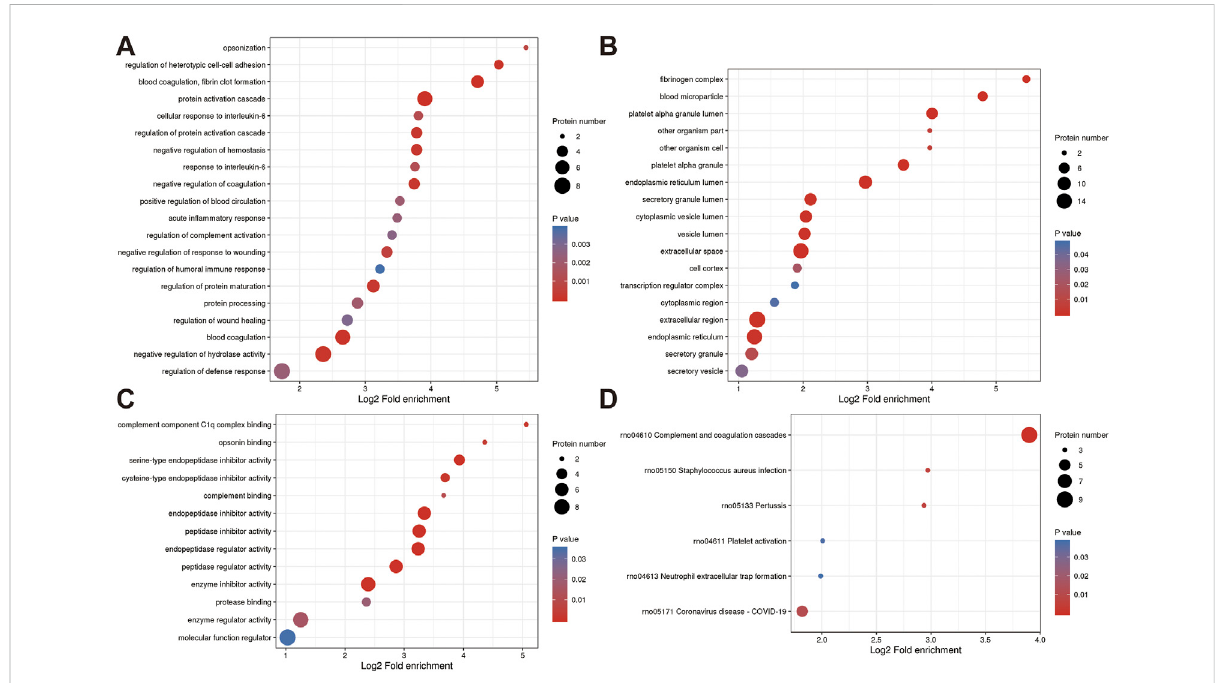
FIGURE 6 Annotation term levels of DEPs between ZY group vs. NC group are indicated as biological process (A) , cellular component (B) , molecular function (C) , and KEGG pathway (D) .